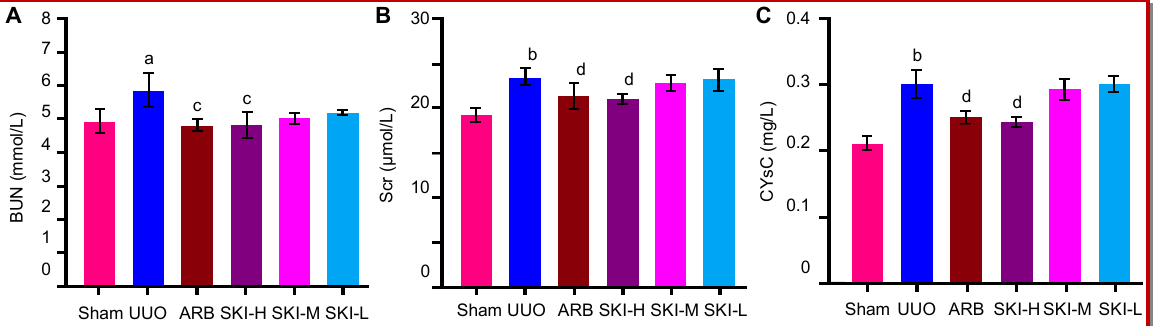
Figure 1: Effects of shenkang injection on blood urea nitrogen (BUN), serum creatinine (Scr) and cystatin C (CysC). The levels were determined by assay kits. Values are presented as mean ± SD; a p<0.05 vs sham group, b p<0.01 vs sham group, c p<0.05 vs UUO group, d p<0.01 vs UUO group; ARB means losartan, UUO means unilateral ureteral obstruction; SKI-H means shenkang injection (7.8 g/kg); SKI-M means shenkang injection (3.9 g/kg); SKI-L means shenkang injection (1.95 g/kg)